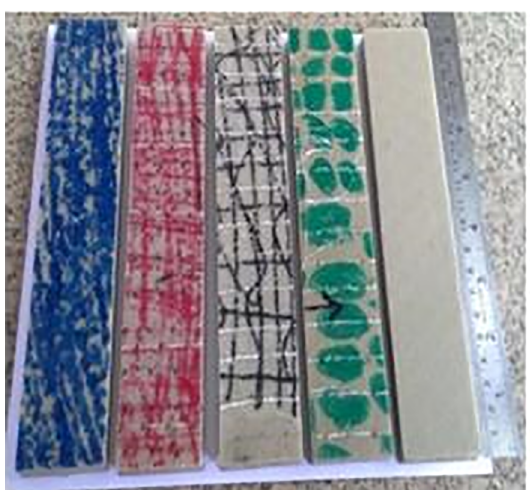
Figure 7. Specimens for core shear test.